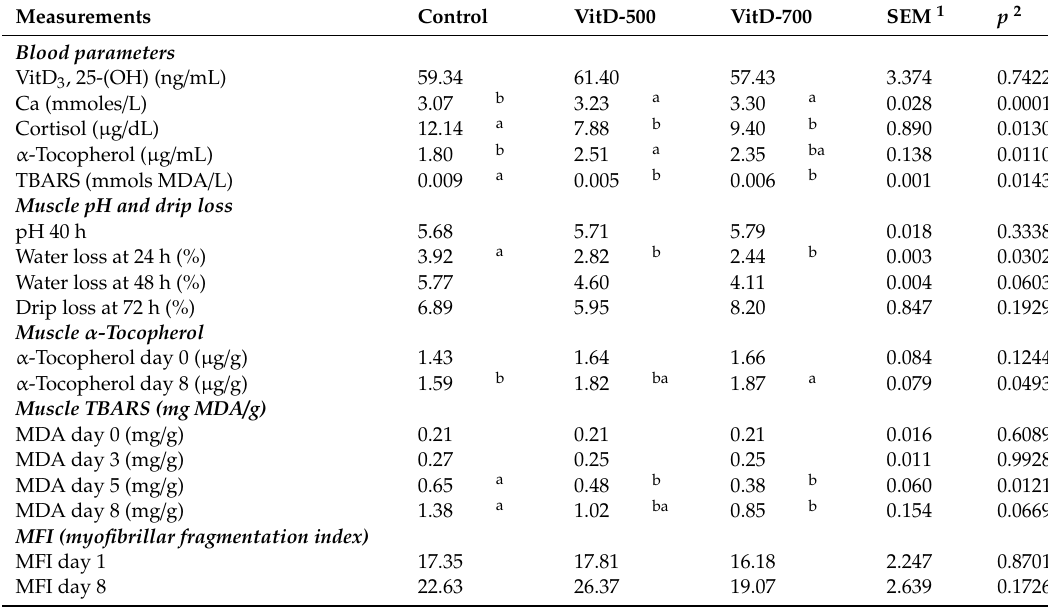
Table 4. Blood parameters and muscle quality measurements from pigs supplemented with vitamin D 3 at di ff erent doses (500,000 UI / L vs. 700,000 UI / L) or without supplementation prior to slaughter (experiment